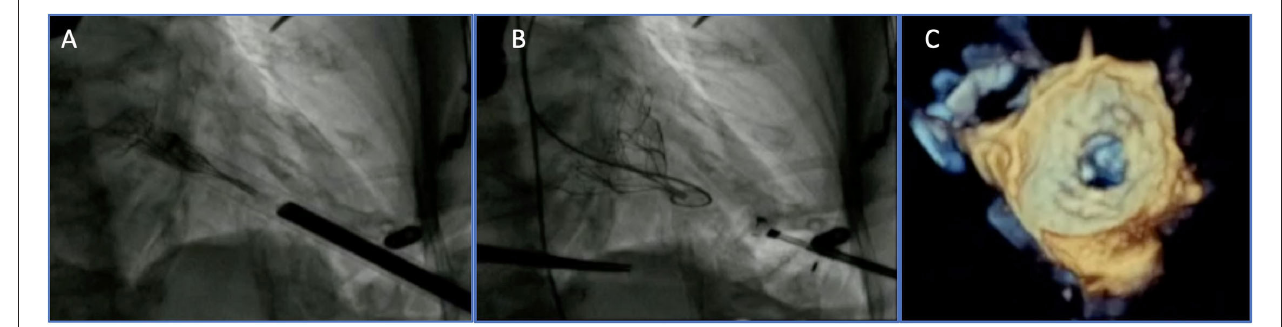
FIGURE 1 | Transapical transcatheter mitral valve implantation (TMVI): Tendyne device before (A) and after implantation (B,C) .